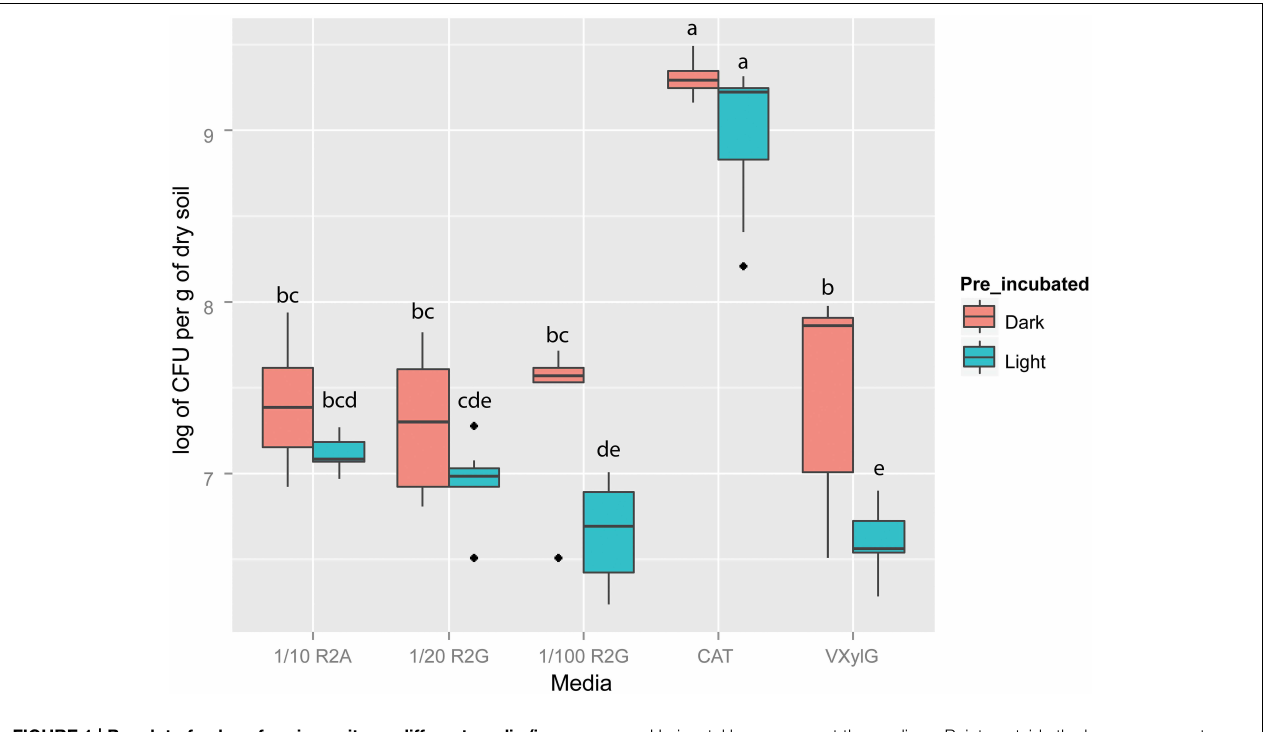
Horizontal bars represent the medians. Points outside the boxes represent outliers. Light/Dark indicate plates counted from samples incubated, respectively, in the light and in the dark. Boxes with same letters are not statistically different according to t- test ( p > 0 . 05